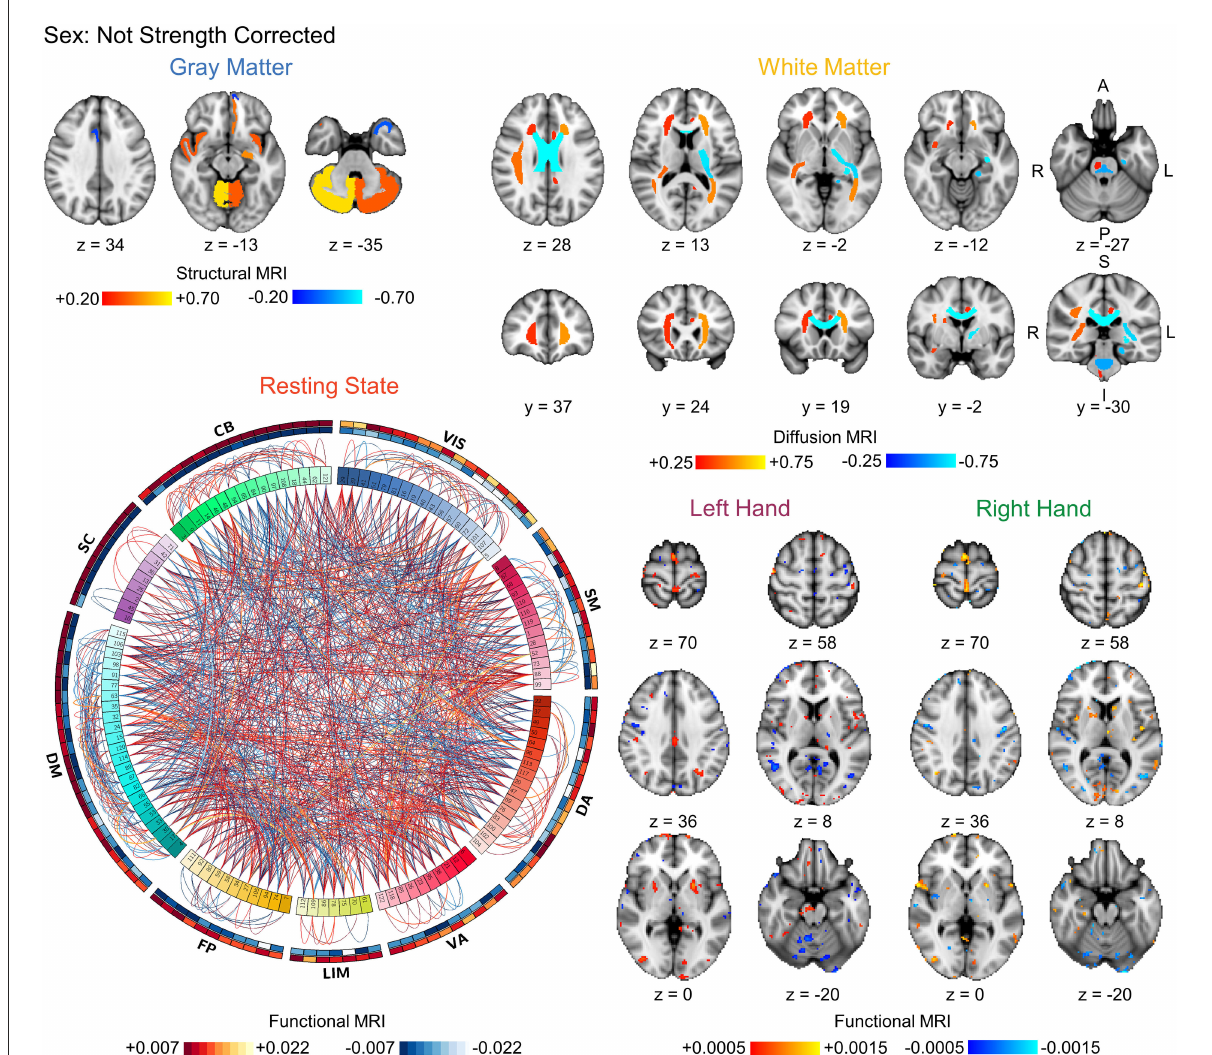
Figure 3. The outer bands in the resting state connectivity graph show the sum of the positive and negative connections passing FDR-correction. VIS, visual; SM, somatomotor; DA, dorsal attention; VA, ventral attention; LIM, limbic; FP, frontoparietal; DM, default mode; SC, subcortical; CB, cerebellar. L, left; R, right; A, anterior; P, posterior; S, superior; I,